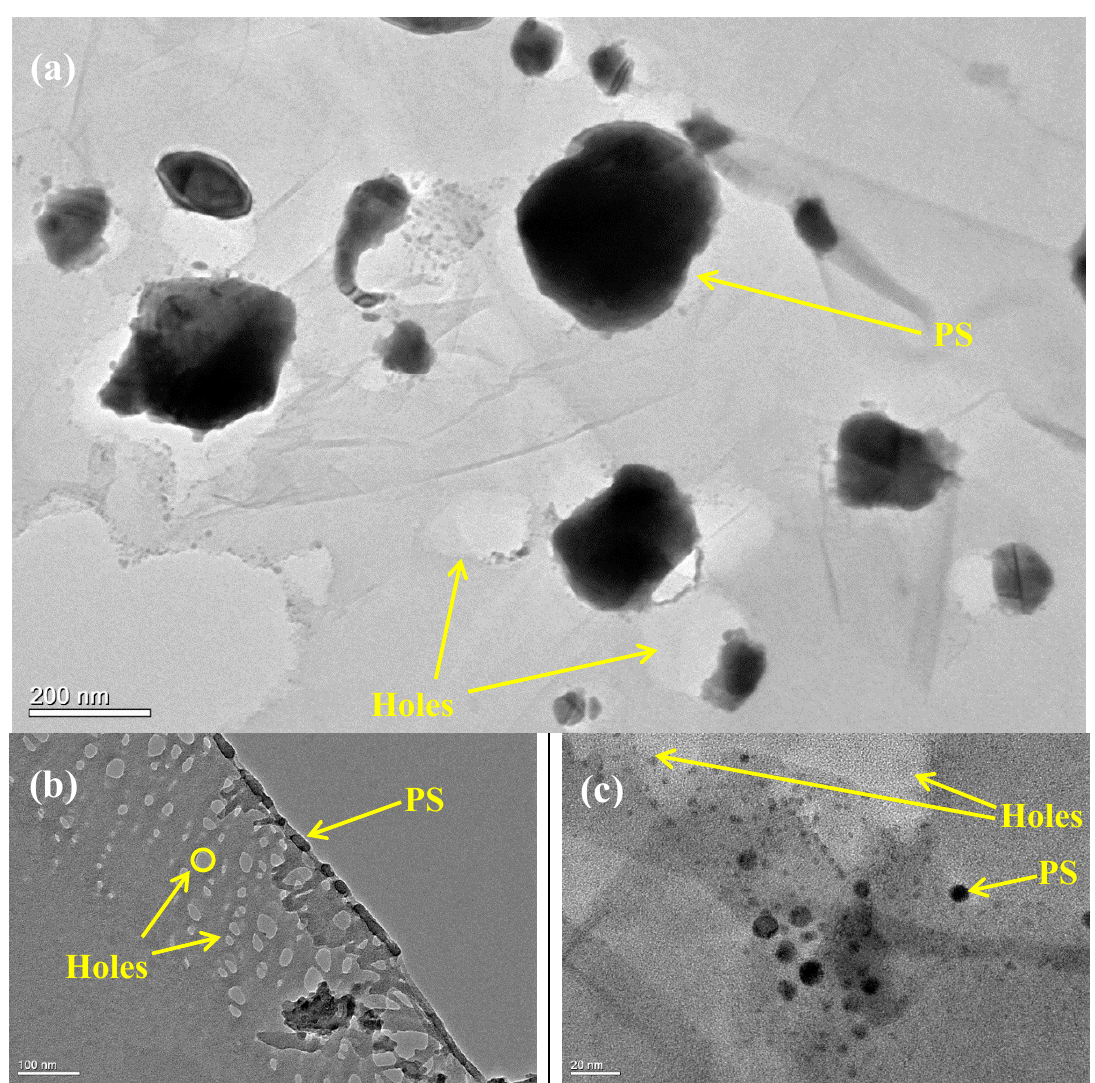
Figure 6. HR-TEM images of the HRGO / PS nanocomposites at ( a ) 200, ( b ) 100, and ( c ) 20 nm.